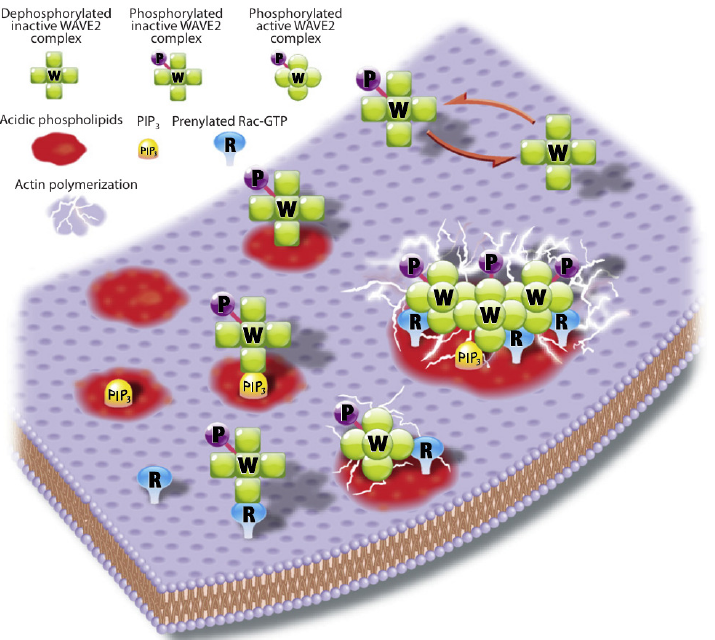
Figure 23. A possible step in the localization of WRC. From Lebensohn and Mitchison [144] with